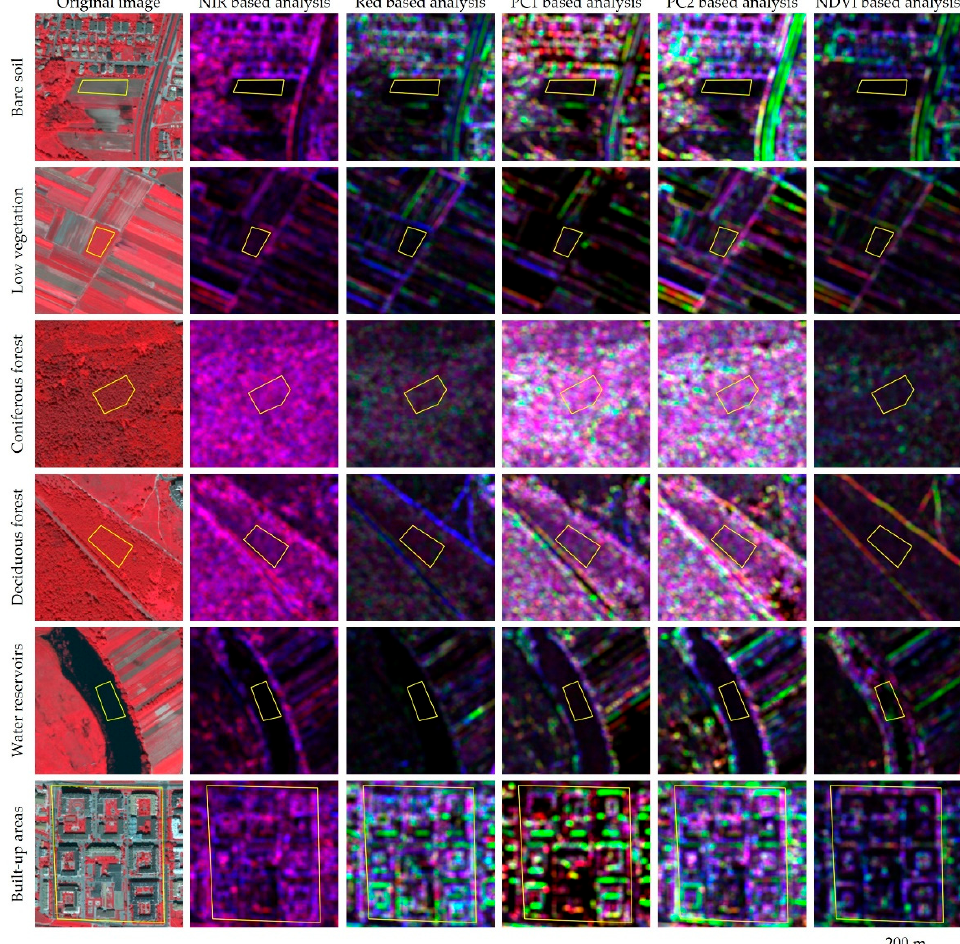
Figure 3. Selected test fields (yellow polygons) of the analyzed classes of land use cover on the WorldView-2 color composition (where: R—near infrared band, G—red band, B: green band) and the results of granulometric analysis (where: R—result of the analysis using closing operation, SE size 1, G—result of the analysis using closing operation SE size 2, B—result of the analysis using opening operation, SE size 1. High pixel brightness means a high value of the granulometric analysis result, i.e., the presence of a significant amount of texture grains of related sizes.